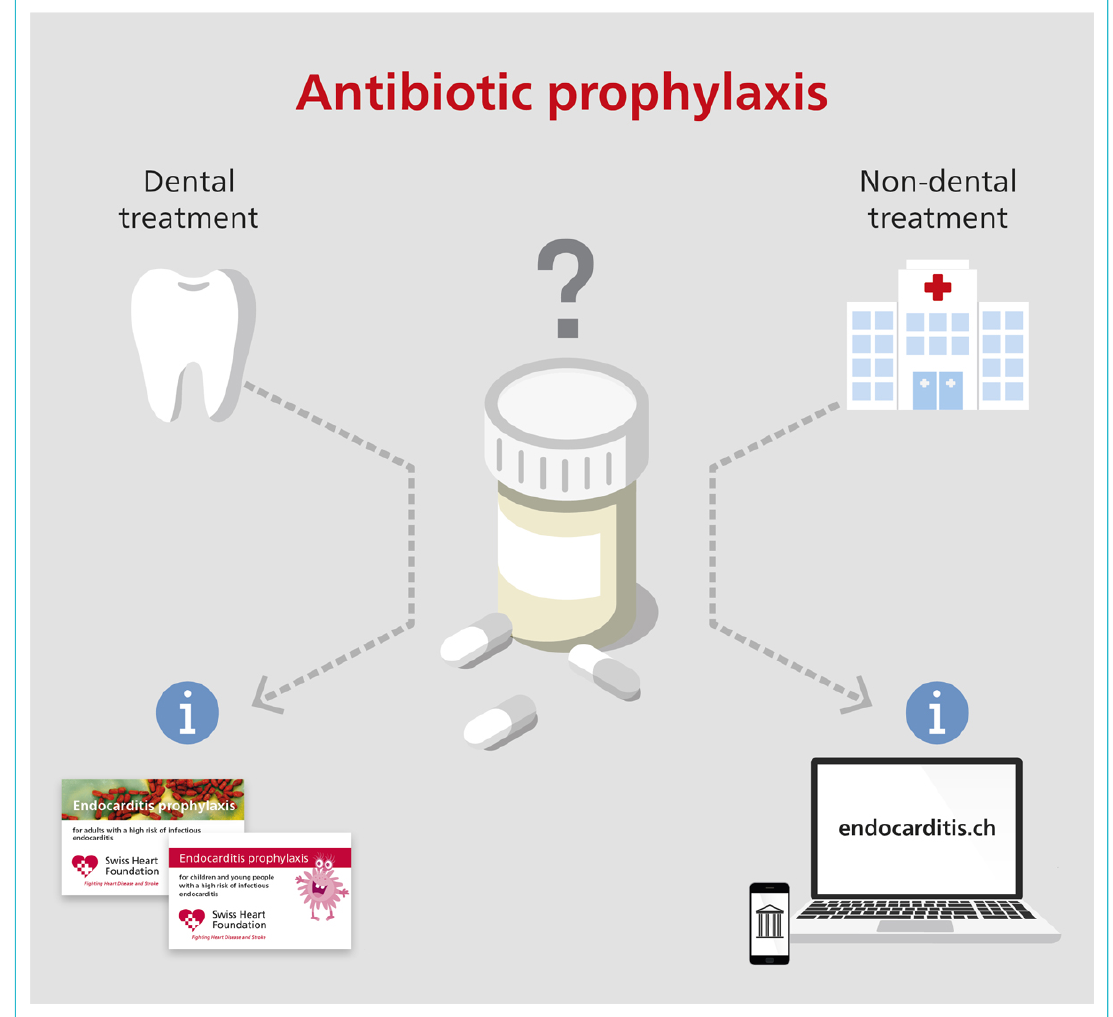
Figure 2: Patients with the highest risk for infective endocarditis require antibiotic prophylaxis prior to dental interventions. Only these patients will also receive a separate antibiotic card. For non-dental interventions, specific recommendations can be found on the corresponding web-